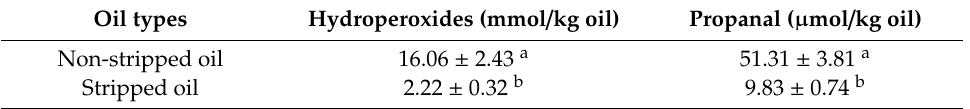
Table 1. Hydrogen peroxide and propanal content in oil samples before and after purification (25 ◦